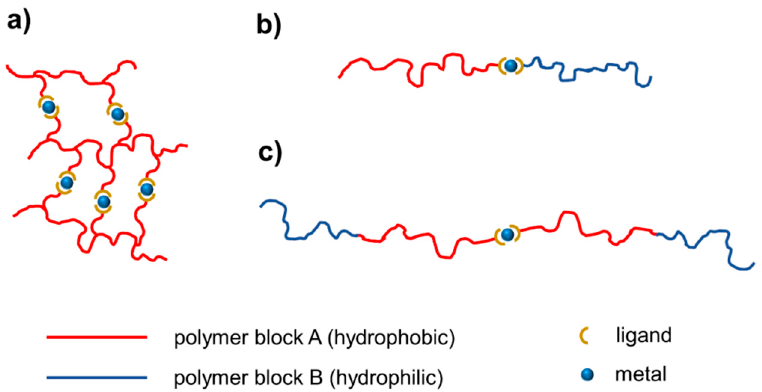
Figure 1. Schematic structures of metallo-polymeric materials: ( a ) cross-linked type, ( b ) amphiphilic block copolymer of the type A-metal-B, and ( c ) amphiphilic block copolymer of the type BA-metal- AB.